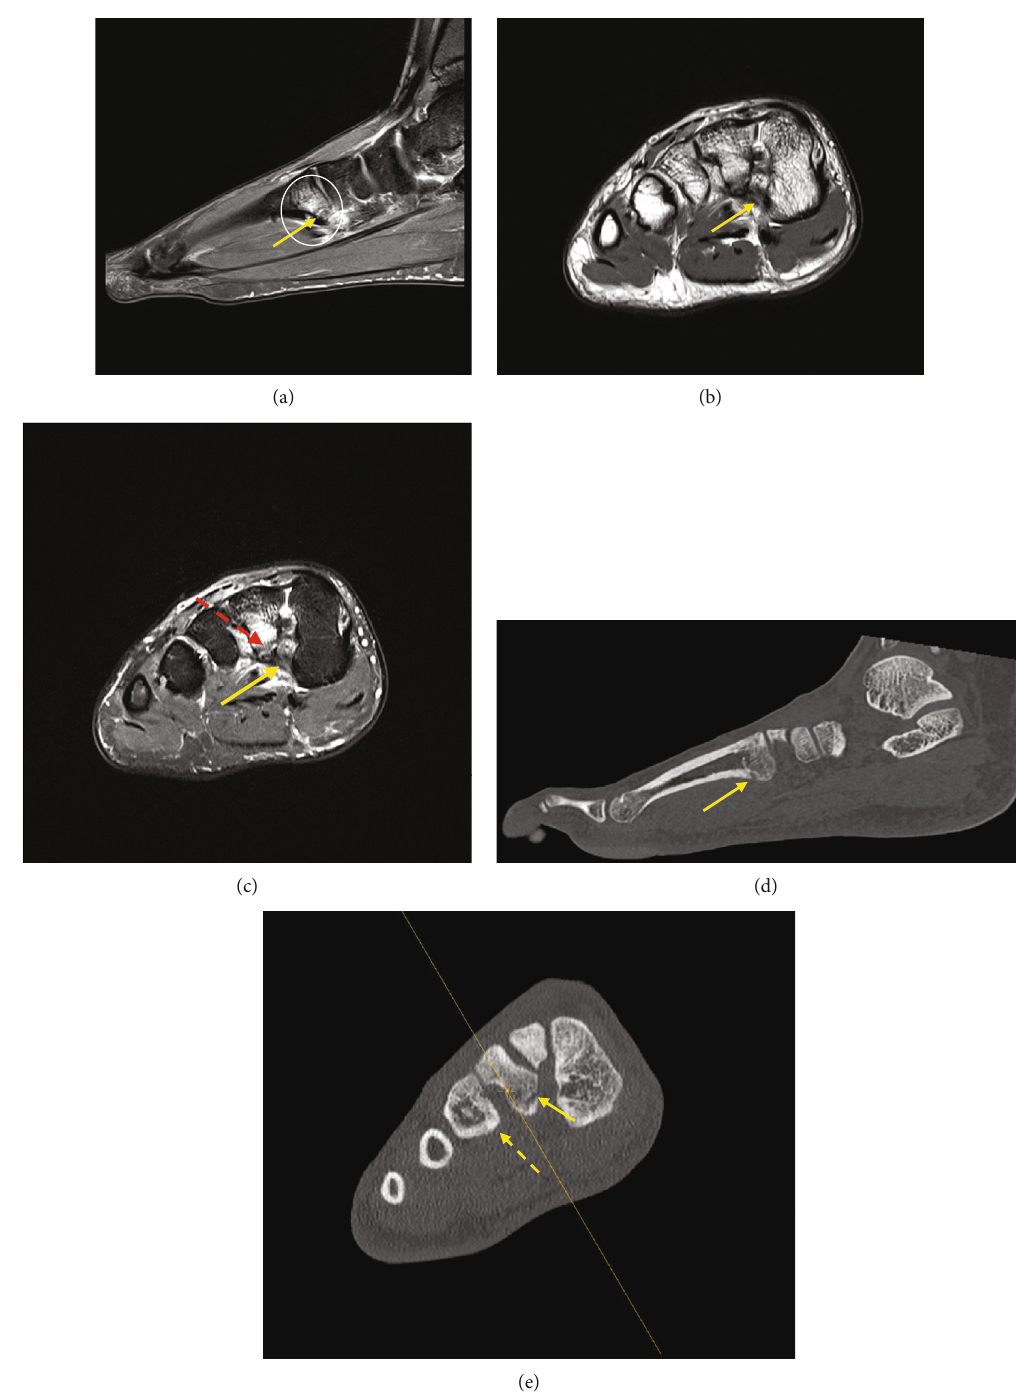
Figure 1: (a) Sagittal proton-density-weighted, fat-suppressed sequence (PDFS) at the level of the second metatarsal. There is localized marrow oedema signal centered at the base of the second metatarsal plantar margin (circled), with adjacent soft tissue oedema. The inferior cortex is thickened, with presence of intracortical high signal consistent with osteitis (arrow). Periosteal oedema present. The intracortical signal traversing the base of the second metatarsal is suspicious for an undisplaced fracture. Axial sequences at the level of the second metatarsal base in proton density (PD) (b) and PDFS (c) show thickening of the plantar Lisfranc ligament (arrow) which returns intermediate signal but is otherwise intact, consistent with grade II sprain or partial tear. Undisplaced fracture at the metatarsal base as shown (dashed arrow). Sagittal (d) and axial (e) CT at the similar level demonstrates the avulsion fracture at the base of the second metatarsal at the site of the plantar Lisfranc ligament insertion (arrow). There is also cortical thickening of the border of the third metatarsal base at the site of plantar Lisfranc attachment (dashed